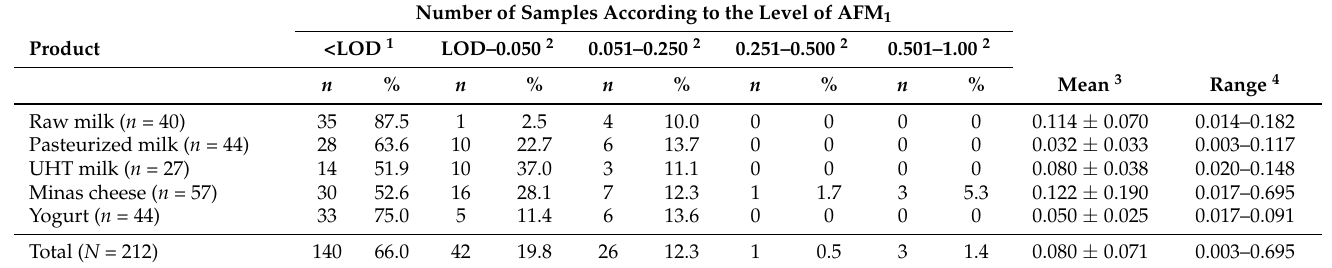
1 LOD: Limit of detection of the analytical methods: 0.0025 µ g/L (raw, pasteurized and UHT milks) and 0.017 µ g/kg (cheese and yogurt). 2 µ g/L or µ g/kg. 3 Values ( µ g/L or µ g/kg) are reported as mean ± standard deviation, for samples analyzed in duplicate containing detectable levels of AFM 1 . 4 Minimum and maximum levels of AFM 1 ( µ g/L or µ g/kg). UHT: Ultra high